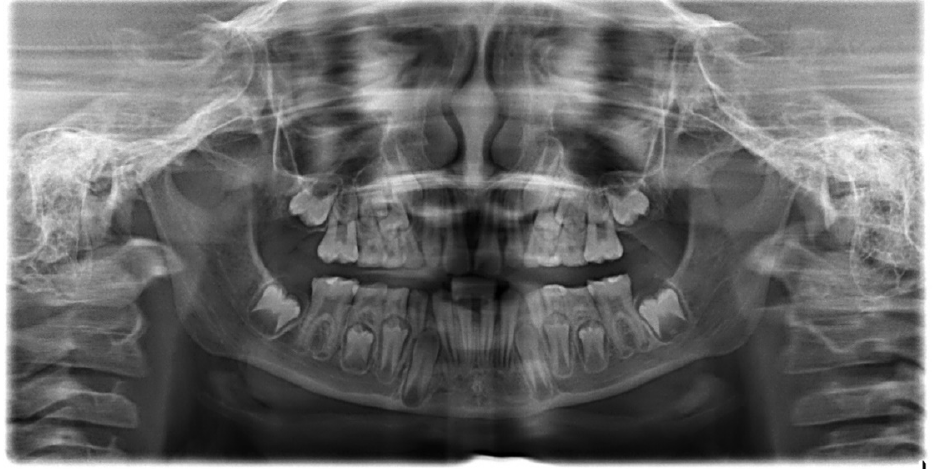
Figure 3. Panoramic X-ray of 7-year-old patient.